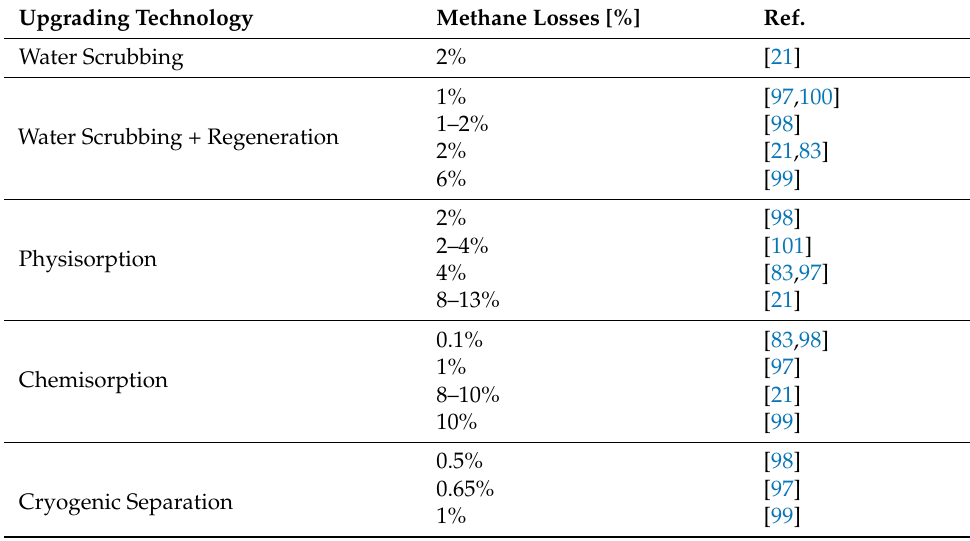
Table 9. Comparison data of methane losses for biomethane production through cryogenic separation versus methane losses in other commercial and well-known technologies. Adapted with permission from Sun et al. [80]; published by Elsevier,